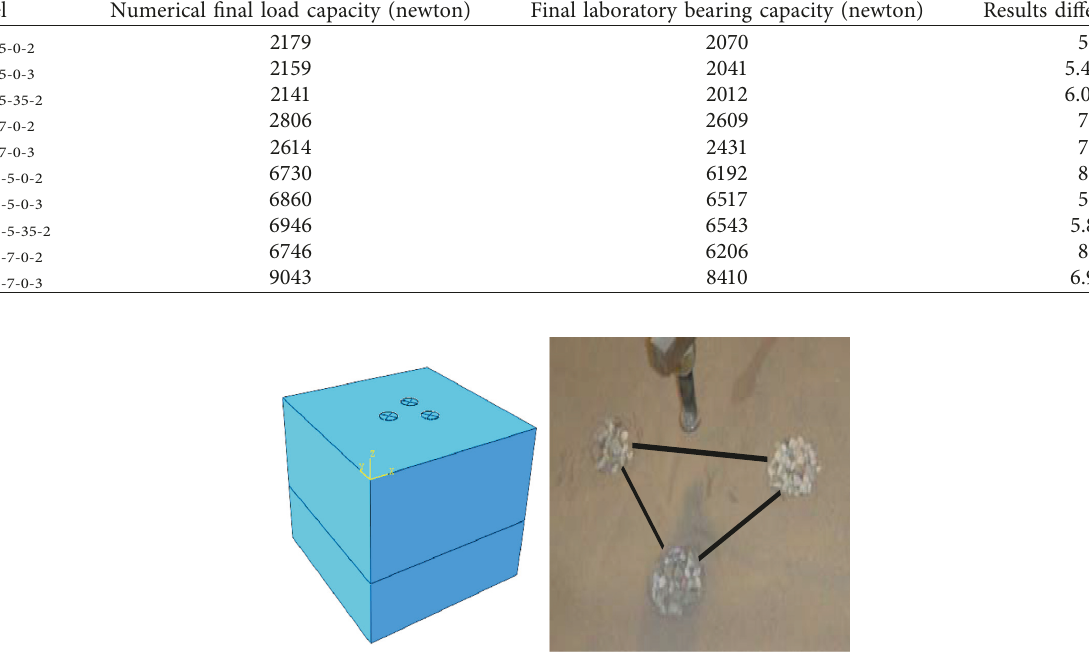
Figure 10: Sandy soil model reinforced with 3 stone